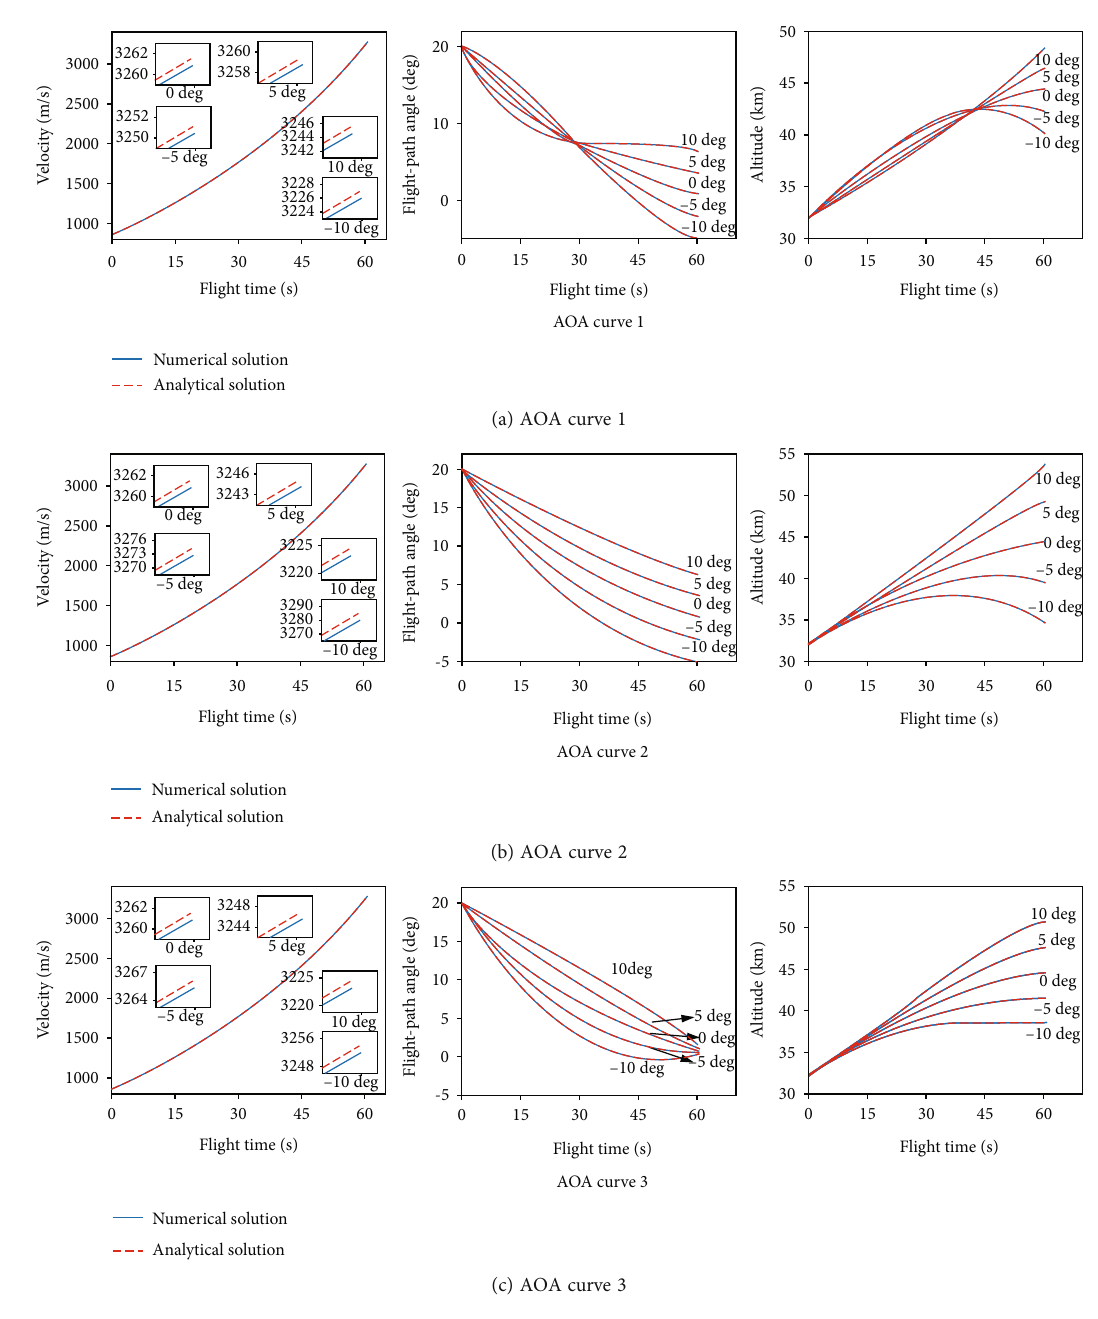
Figure 4: Ascent state histories with various AOA